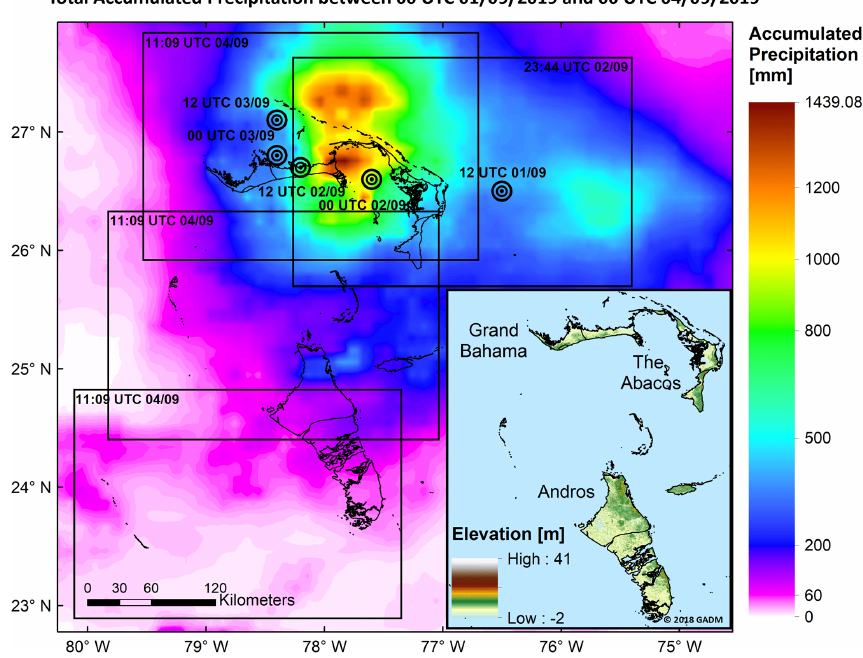
Figure 1. Background map: IMERG total accumulated precipitation between 00:00UTC 1 September and 00:00UTC 4 September 2019 (shaded), boundaries of Sentinel-1 SAR images (rectangles), and location (targets) of Hurricane Dorian from National Hurricane Center public advisories (NHC, 2019). Bottom right front map: elevation (Farr et al., 2007) of the study area. In both maps, Bahamas boundaries are delineated using the Global Administrative Areas dataset (Hijmans and University of California,